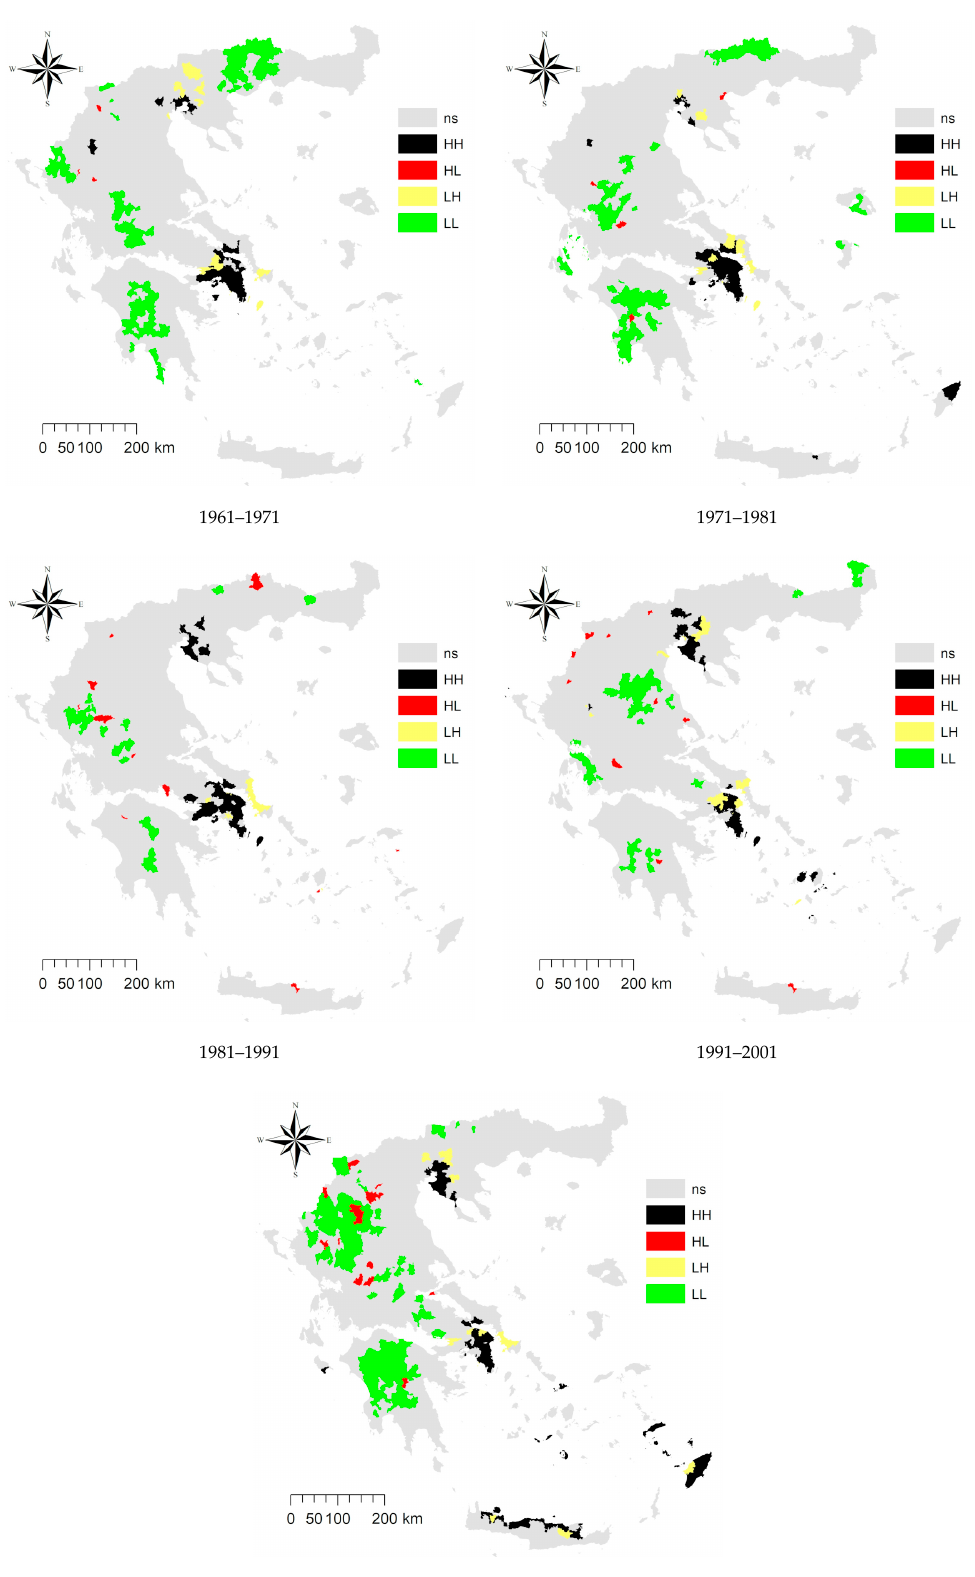
Figure 5. Maps illustrating spatial clustering of population growth in Greece by decade (HH: High–High hotspots, HL: High–Low coldspots, LH: Low–High coldspots, LL: Low–Low hotspots, ns: